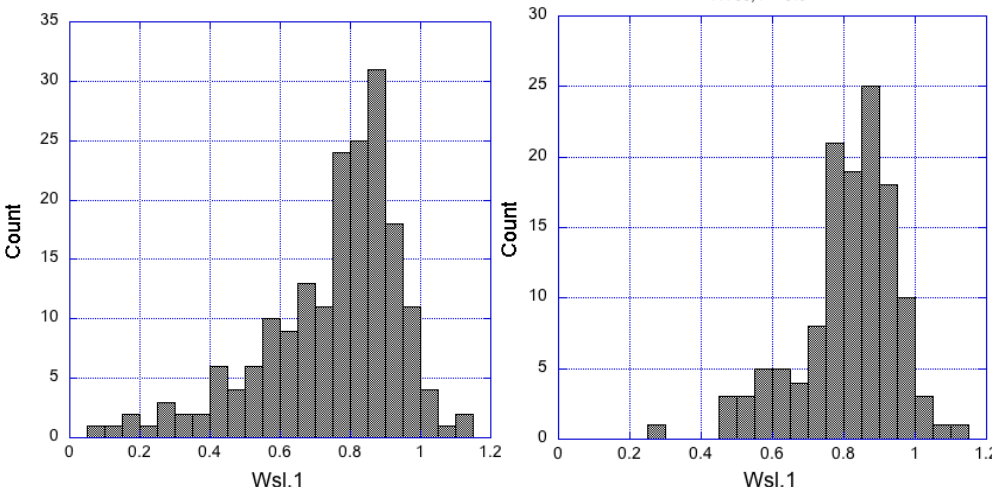
Fig. 5. Histograms of the 1min Wal´en slope magnitudes for all 188 cases (left), except for one case that is slightly off-scale, with median 0.80, and for the 127 cases with HT cc , 1 ≥ 0.9 (right), with median 0.84.